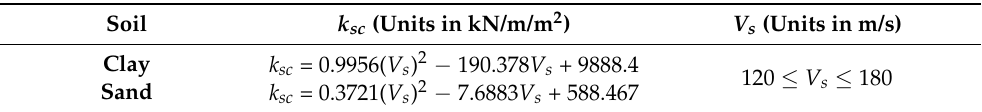
Table 5. The normalized function f(x) for the coefficient of subgrade reaction. f(x) Where 0 ≤ x ≤ L /2 (Unit of x : m)